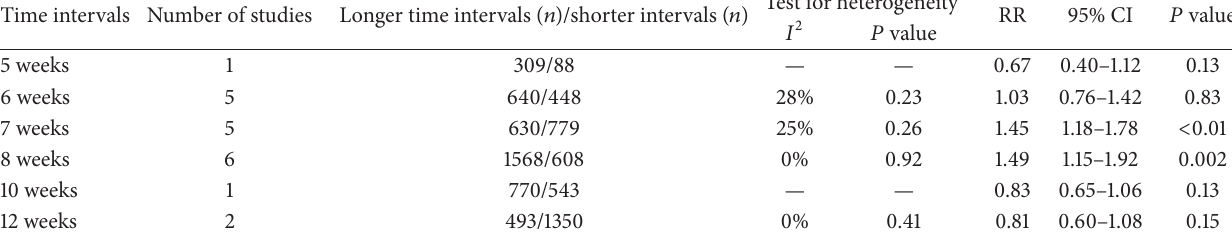
Table 3: Meta-analysis of pCR rate according to time